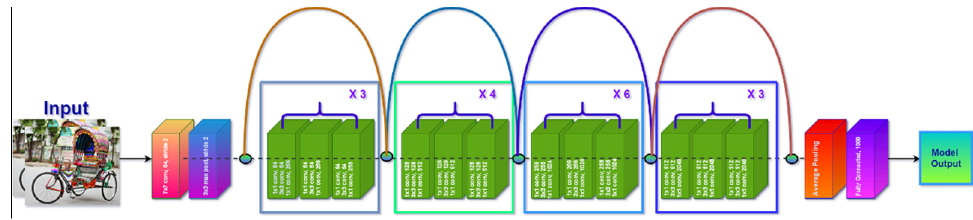
Figure 5. A pre-trained ResNet-50 network with residual connections.